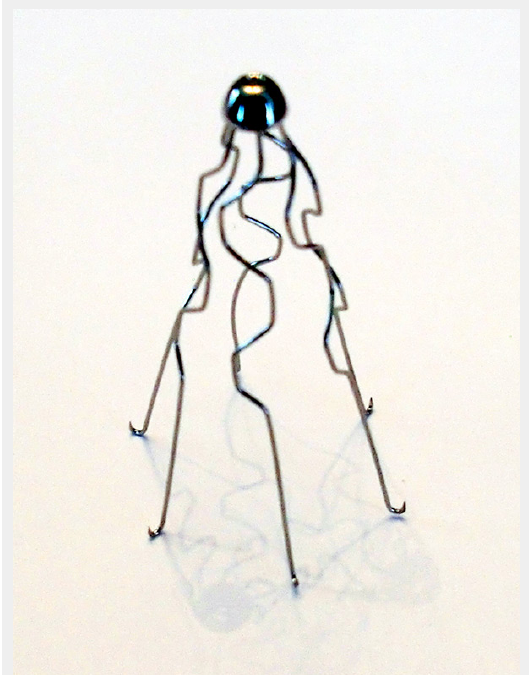
Original Greenfield vena cava filter (catalog no. 2846). This device was designed for permanent implantation including sharp hooks at the bottom to prevent migration. In contrast, retrievable caval filters have a hook or a graspable area at the tip that allows for traction and refolding into a